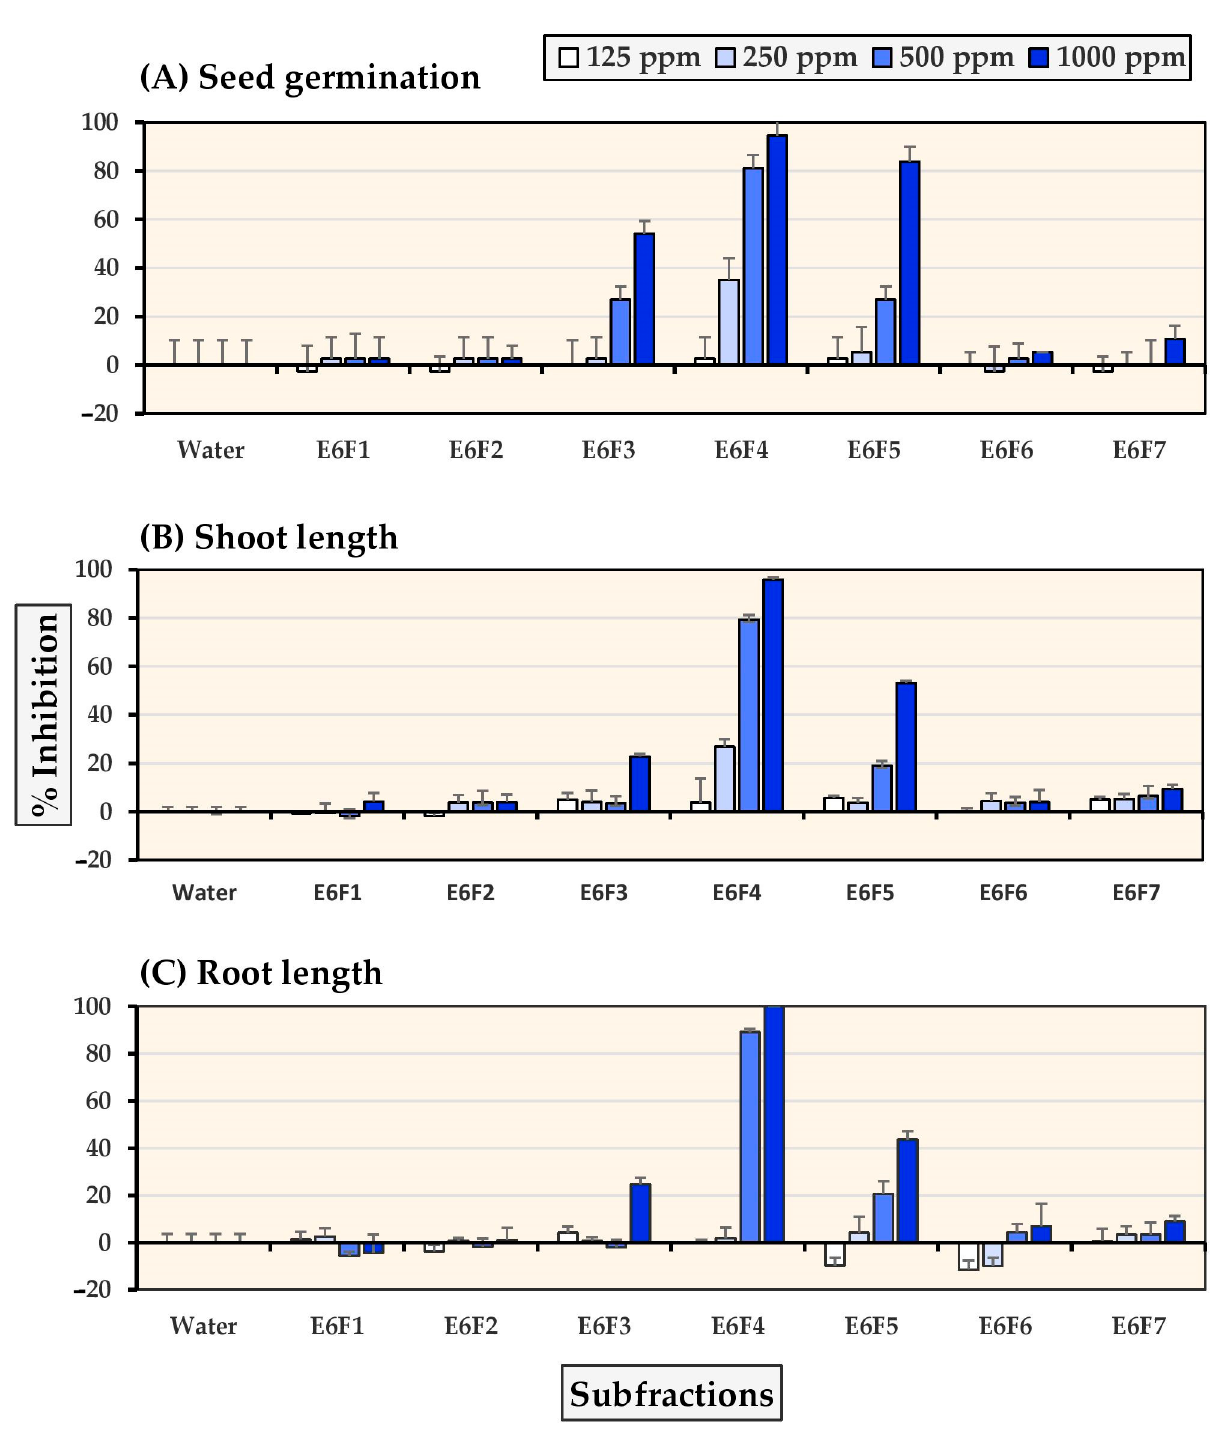
Figure 2. Inhibitory effects of S. platensis E6 subfractions on ( A ) seed germination, ( B ) shoot length, and ( C ) root length of barnyardgrass. Distilled water was used as a control.